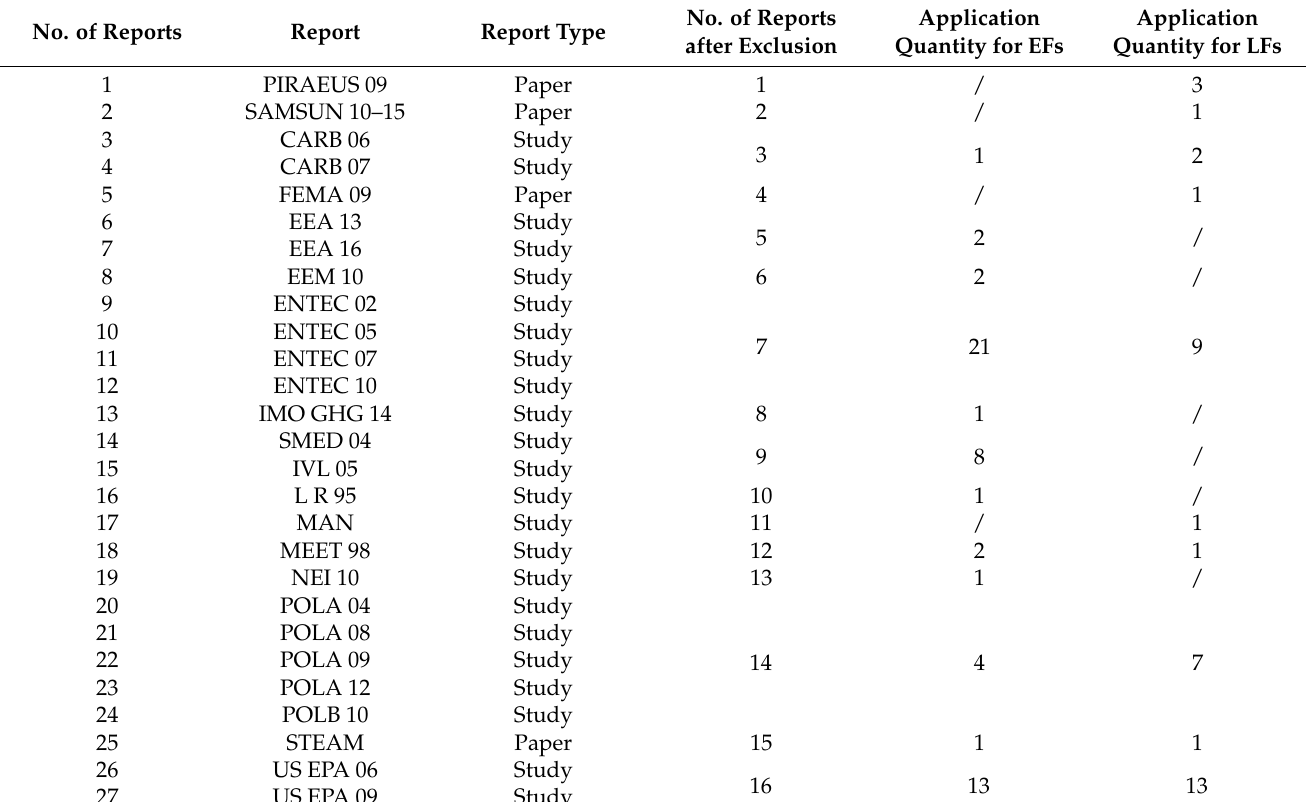
Table 4. Exclusion and application quantity of references based on